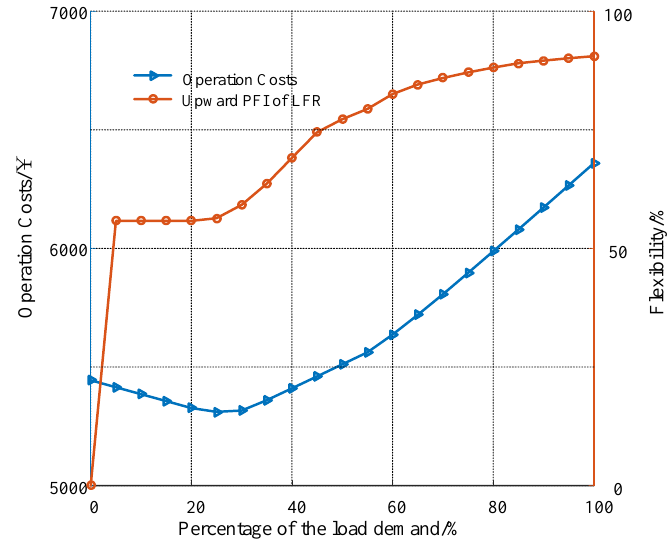
Figure 11. Impact of the comprehensive demand response ratio on PIES.